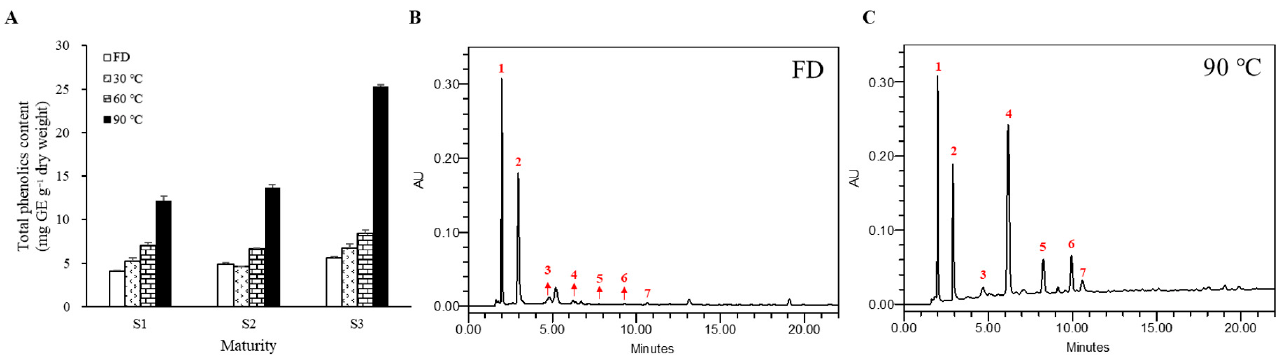
Figure 3. Changes of total phenolic content ( A ) in thermal processing of M. charantia . ( B ) Chromatograms of phenolic compounds in ( B ) freeze-dried (FD) and ( C ) 90 °C heat-treated S3 detected at 280 nm using HPLC analysis.